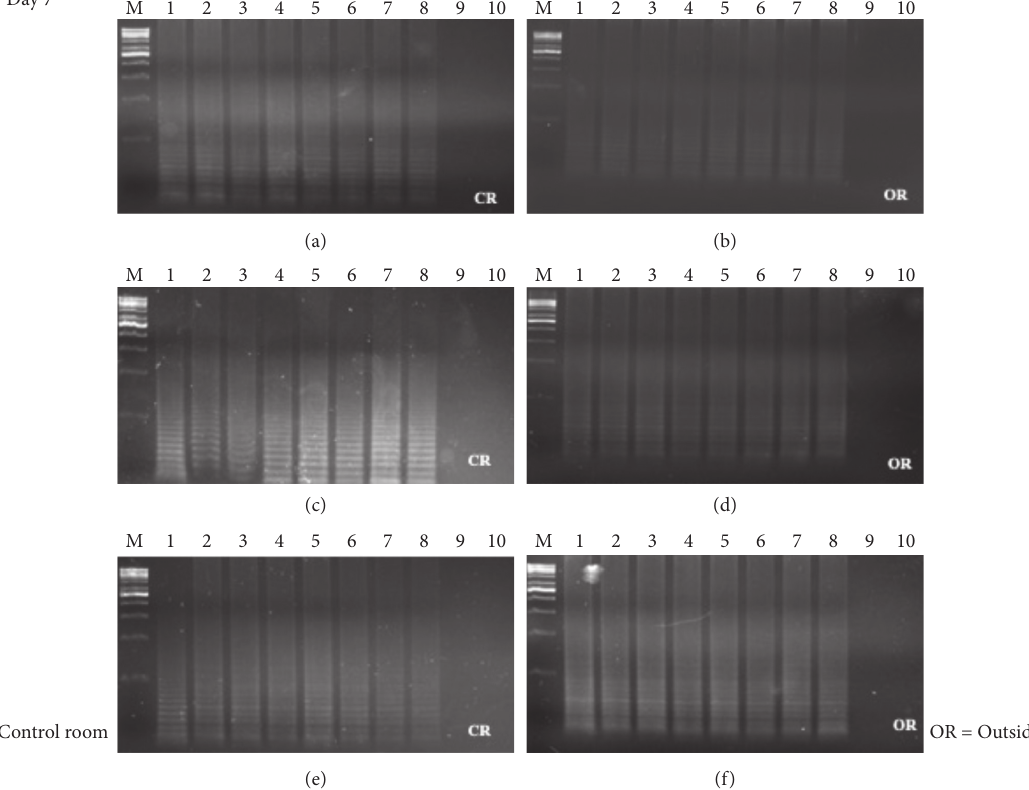
Figure 3: Time course detection of DNA sample stained on different surfaces in day 7. (a), (b) brick, (c), (d) cloth, and (e), (f) tile. M � 1kB DNA ladder, lane 1–9 � male sample 1–8, and lane 9, 10 � female sample